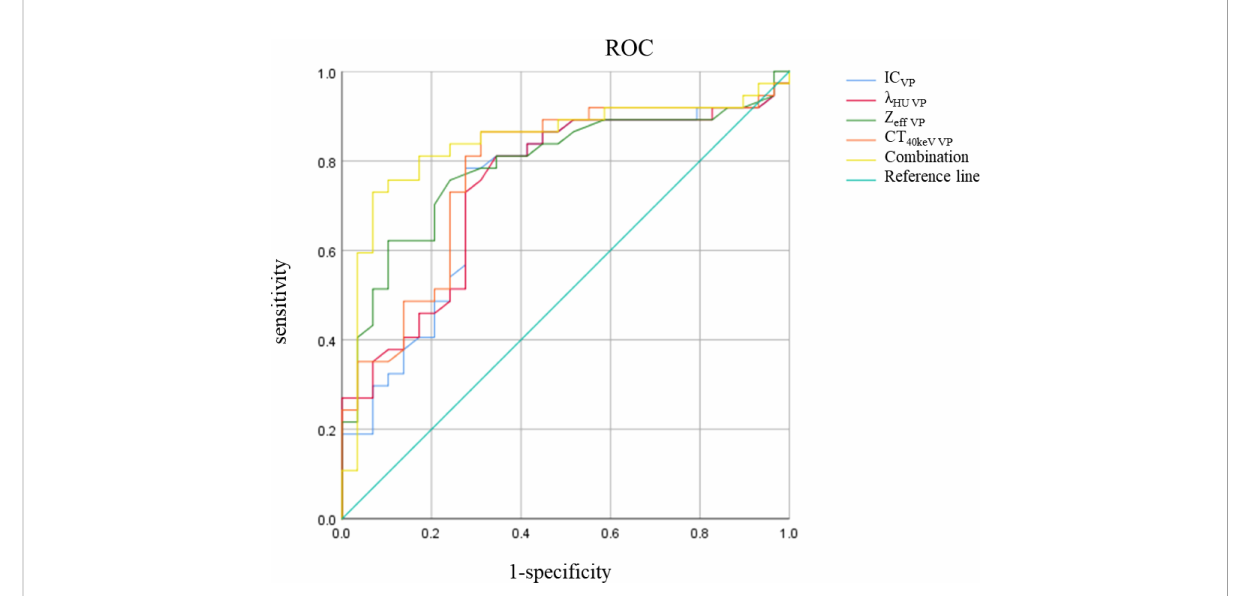
FIGURE 4 IC, l HU , Z eff , CT 40keV , Combination ROC curve in VP. The combination of IC, l HU, CT 40keV and Z eff in VP had the highest diagnostic ef fi cacy.